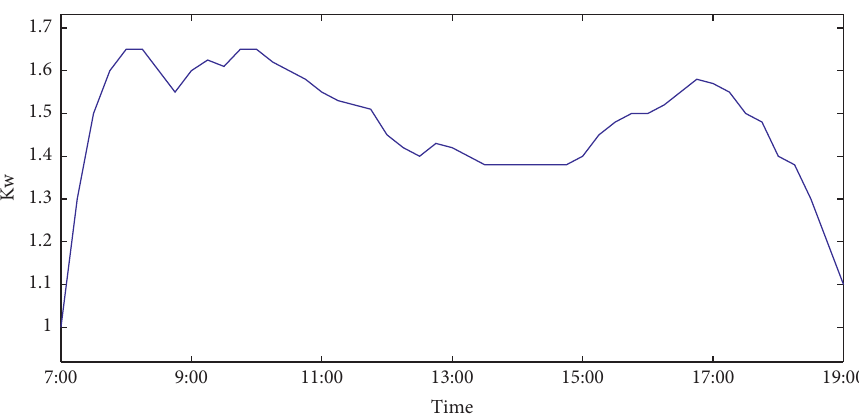
Figure 10: Indoor thermal load interference.